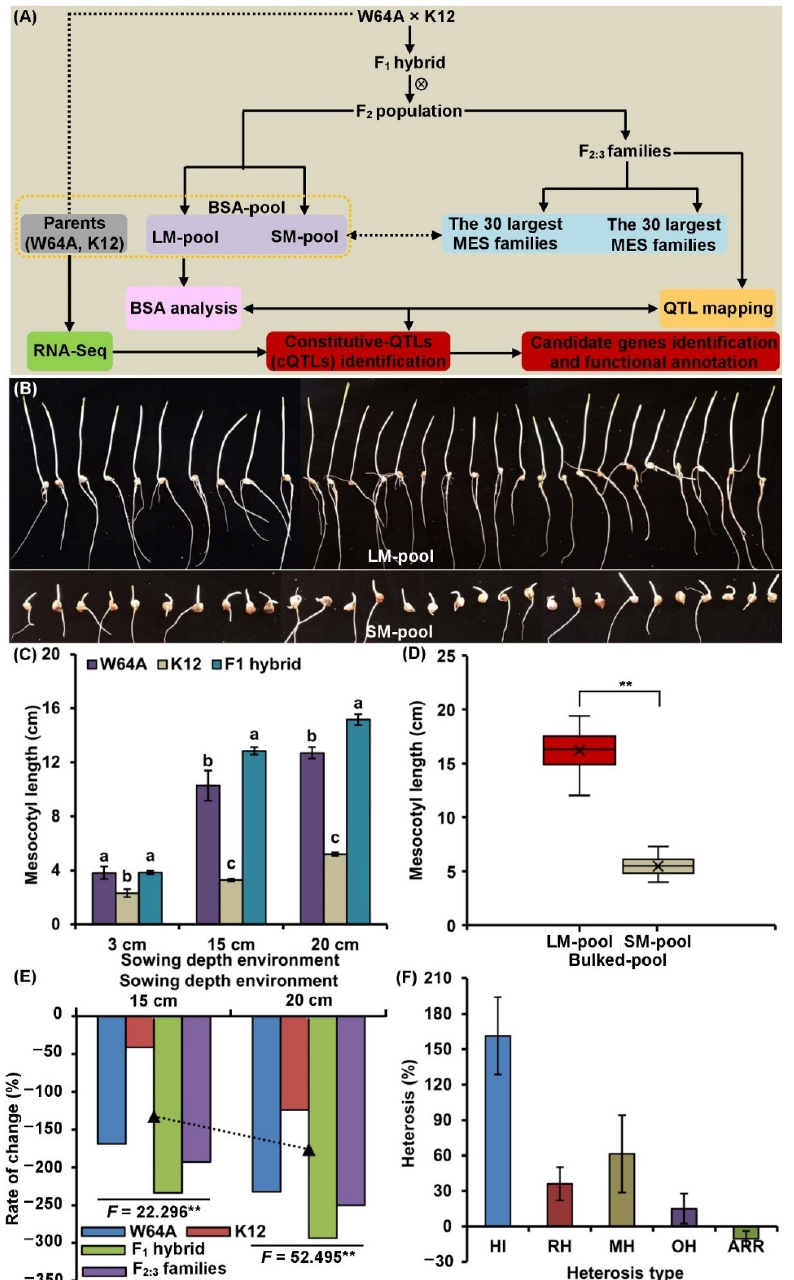
Figure 1. Performance of mesocotyls at three sowing environments. ( A ) Schematic diagram of experimental population construction and analysis. ( B ) Performance of the mesocotyl length (MES) of LM pool (the 30 largest MES ‐ pool) and SM pool (the 30 shortest MES ‐ pool) at a 20 cm sowing environment. ( C ) MES of the parents (W64A and K12) and their F 1 hybrid under 3, 15, and 20 cm sowing environments, respectively; different lowercase letters with different materials in a single environment indicated a significant difference with p < 0.05 (ANOVA). ( D ) Boxplot of MES showing the difference between LM pool and SM pool used for a BSA under 20 cm sowing environment; asterisks indicated significant differences (** p < 0.01; ANOVA). ( E ) Compared to 3 cm sowing conditions, the rate of change (RC) of MES in two parents, F 1 hybrid, and F 2:3 population under 15 and 20 cm sowing conditions, respectively; asterisks indicated significant differences (** p < 0.01; ANOVA). ( F ) Heterosis analysis (HI: F 1 heterosis index, RH: relative heterosis, MH: mid ‐ parent heterosis, OH: over ‐ parent heterosis, ARR: F 2:3 advantage reduction rate) of MES.